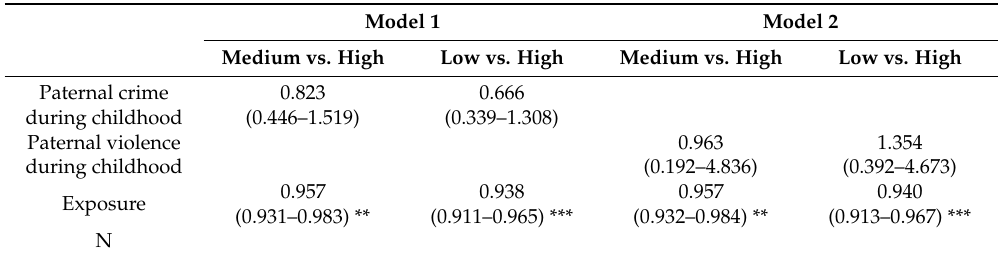
Table 4. Multinomial logistic regression analyses predicting offspring’s heart rate